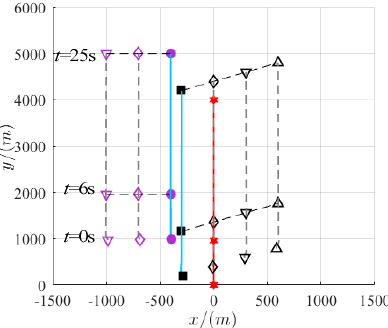
Figure 6. Top view of MAV/UAVs group formation.